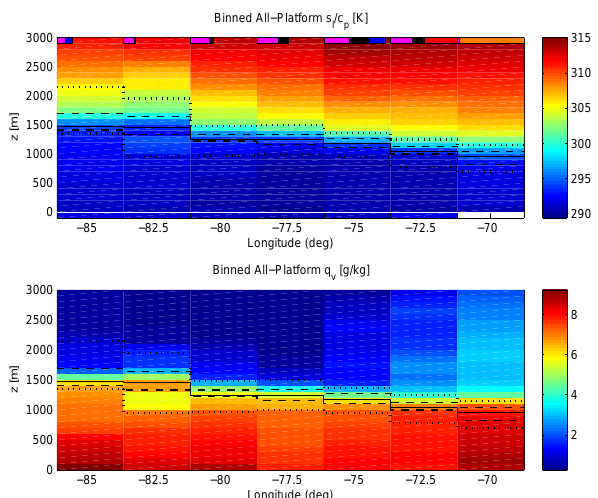
Fig. 5. Multiplatform longitude-height cross-sections of 16 October–15 November 2008 mean s/c p (top) and q v (bottom) along 20 ◦ S in 2.5 ◦ longitude and 100m height bins. In each longitude bin, the statistics of inversion base height (diagnosed as a local tem- perature minimum) across the contributing profiles are shown using dotted lines for the maximum and minimum, dashed lines for the 25 / 75 percentiles and a solid line for the median. In the upper plot, the shades below z = 0 show Reynolds SST, and the colored rectan- gles at the top of each longitude bin indicate the fraction of days in the month with contributing observations from each platform (ma- genta: C130, black: BAe146 dropsondes, blue: Brown sondes, or- ange: Iquique sondes, red: Twin Otter profiles).